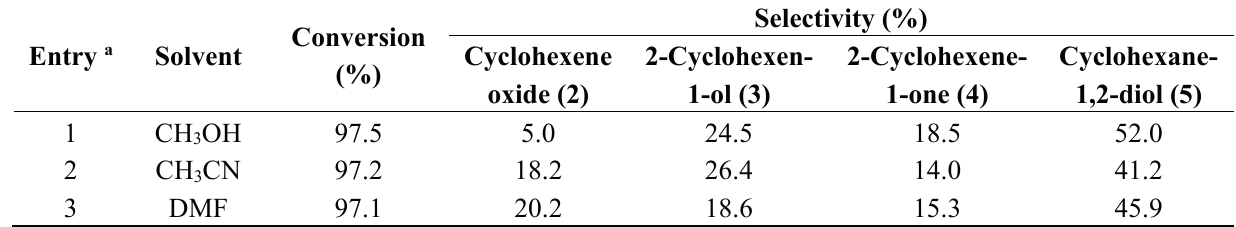
Table 6. The selective oxidation of cyclohexene to 1,2-diols catalyzed by iron (III) phthalocyanines with triflate as a counter anion using H 2 O 2 as an oxidant in different